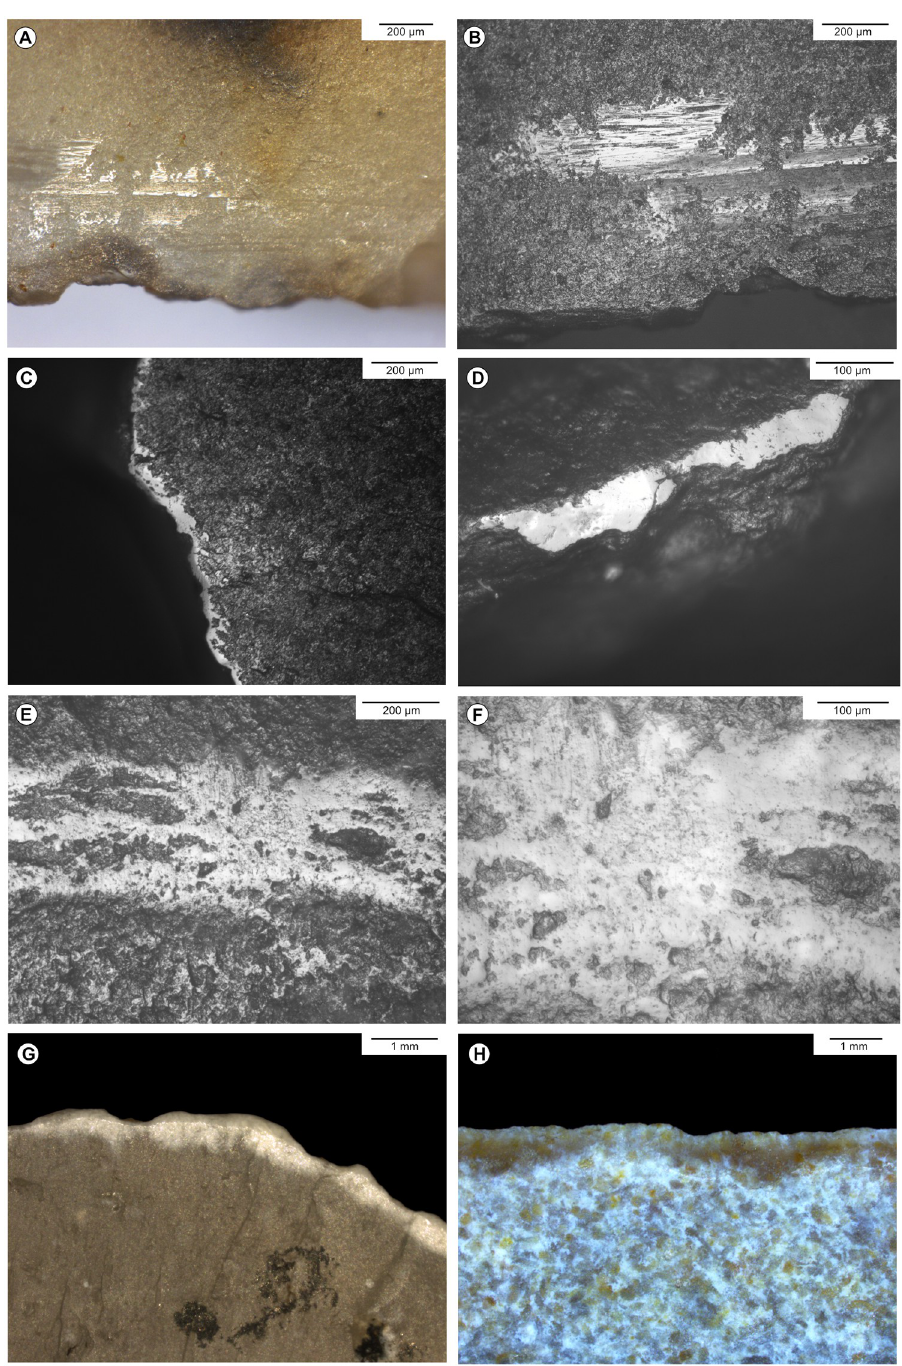
Fig 4. Examples of post-depositional alteration on the archaeological material. A, B-Striated bright spot on a bladelet from the Blanchard cave, layer B5, credits: Gauvrit Roux, 2019. C-Marginal non-striated bright spots on the distal edge of an endscraper from the Blanchard cave, layer B3. D-Marginal non-striated bright spots on the distal edge of an endscraper from the Blanchard cave, layer B4/B5. E, F-Rounding and bright spot on the ridge of a burin from La Marche, credits: Gauvrit Roux, 2019. G-Marginal white patina on the edge of an endscraper from La Marche. H-Fresh scars interrupting white patina on the lateral edge of a burin from La Marche.